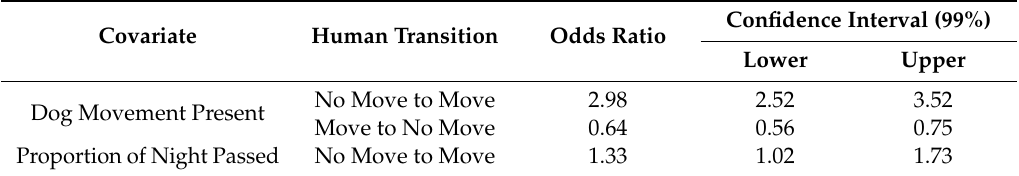
Table 3. E ff ects of dog movement and proportion of night passed on human transitions from a moving to a non-moving